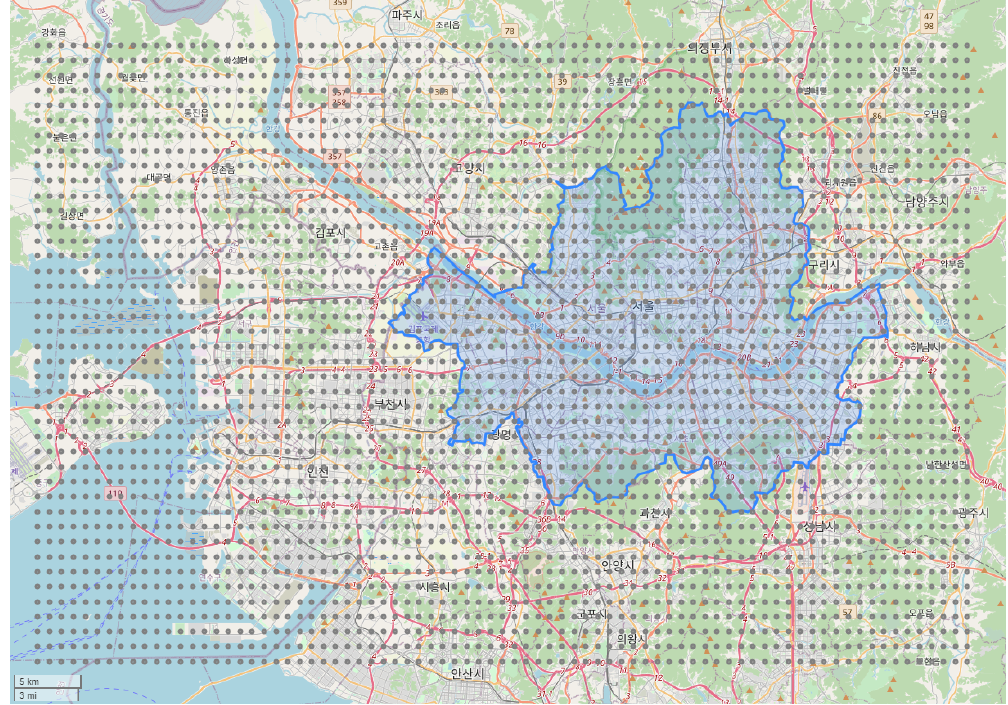
Figure 1. Grid setting of research area where the blue area represent Seoul, the grey dot indicates the position of each grid point, and the red lines are the major highways in the